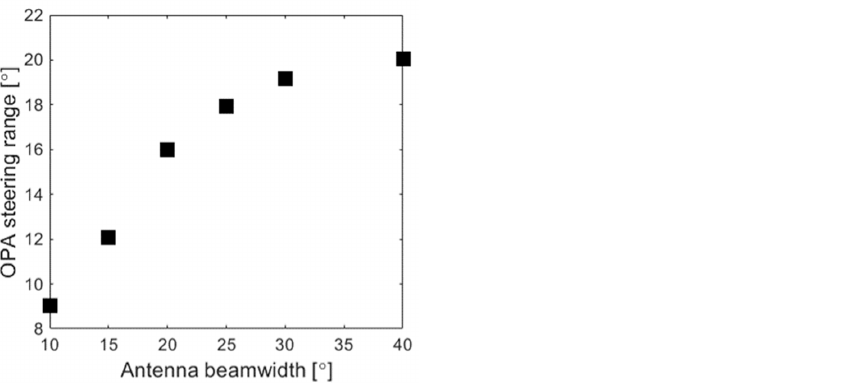
Figure 8. Simulated steering range ( Δ θ ) as a function of the antenna angular beamwidth in the elevation angle ( θ ) for an 870-element optical phase array.